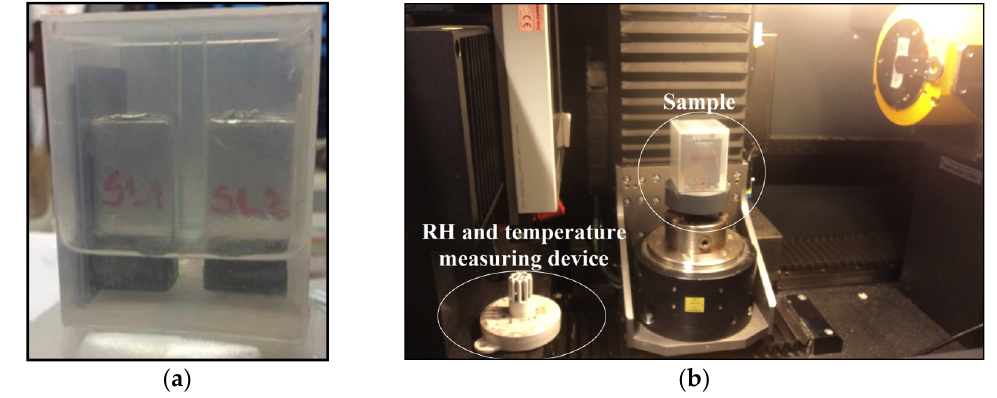
Figure 2. Samples for moisture exchange measurements; ( a ) two specimens are placed in a plastic container prior to X-ray testing; and ( b ) the X-ray system with the position of the sample and temperature and RH sensors.